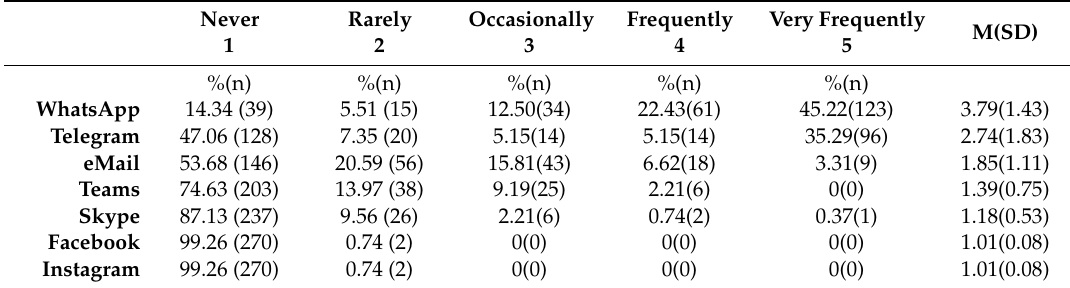
Table 5. Channels used to communicate among team colleagues. Frequency of